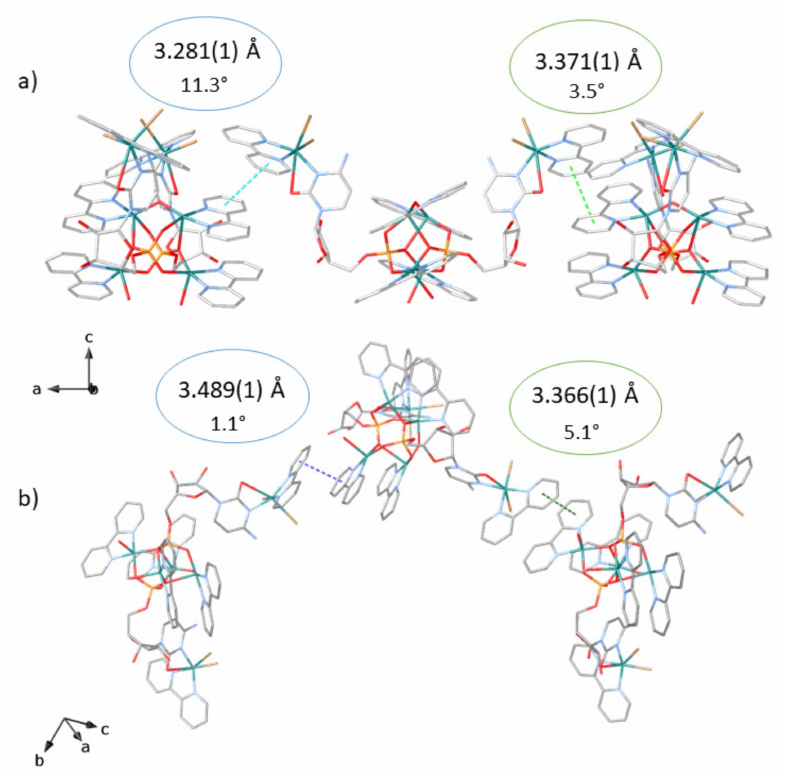
Figure 2. Perspective view of π - π stacking interactions within neighboring hexanuclear fragments: ( a ) (interplanar distances and dihedral angles of 3.281(1) Å (light blue dashed lines) and 11.3 ◦ , and 3.371(1) Å (light green dashed lines) and 3.5 ◦ , respectively); ( b ) (interplanar distance and dihedral angles of 3.489(1) Å (light blue dashed lines) and 1.1 ◦ , and 3.366(1) Å (light green dashed lines) and 5.1 ◦ , respectively). Copper, cyan spheres; phosphorous, orange; oxygen, red; nitrogen, blue; carbon, grey; bromide, brown. Hydrogen atoms and lattice water molecules have been omitted for the sake of